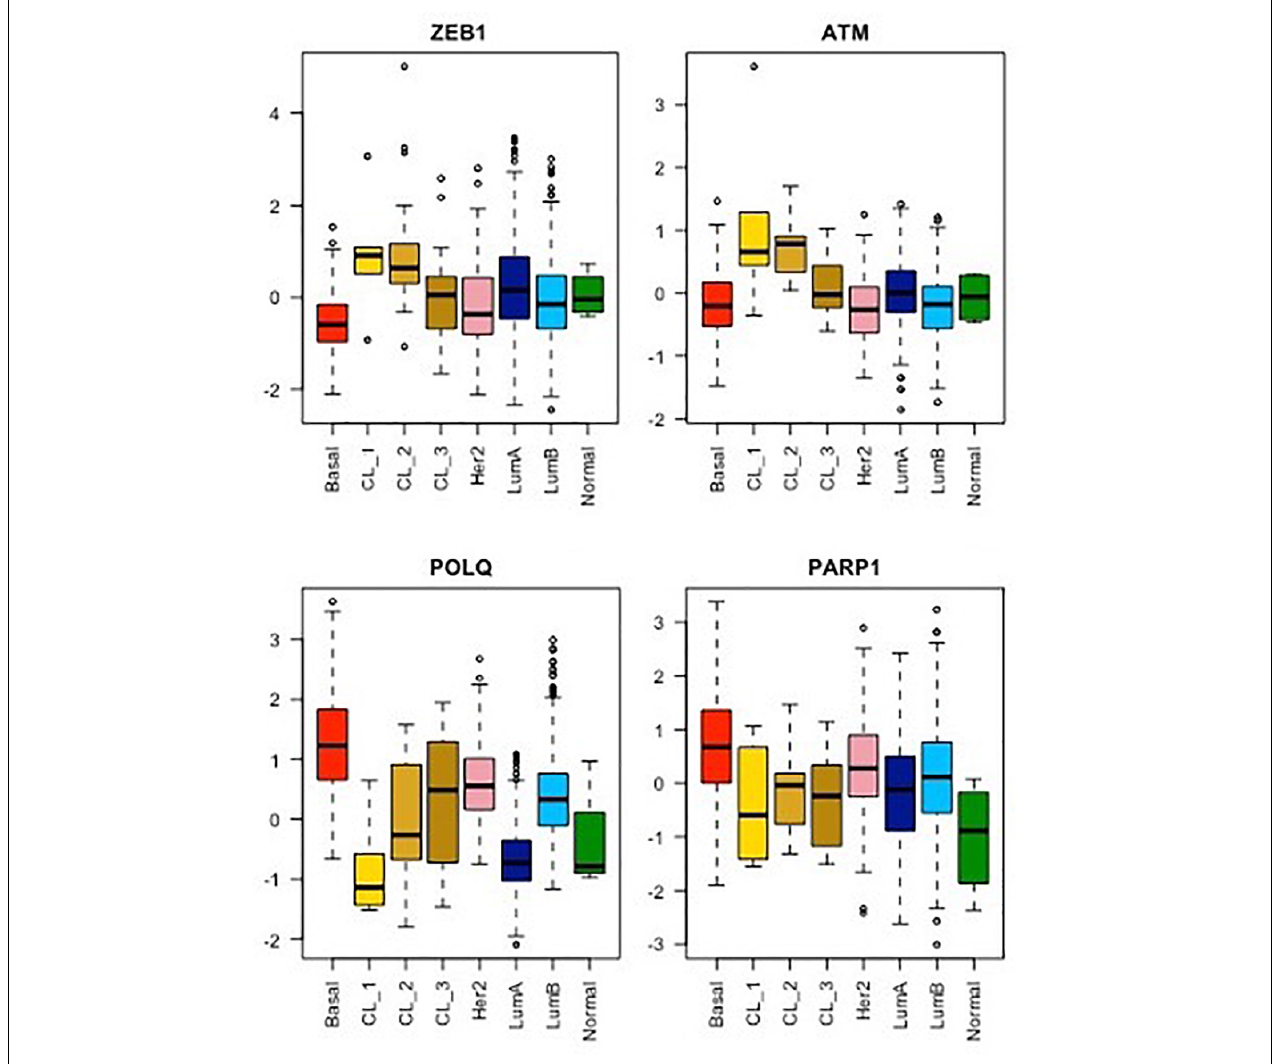
FIGURE 2 | mRNA expression analysis of ZEB1, ATM, POLQ, and PARP1 for each breast cancer molecular subtype from the METABRIC cohort. As already shown, the CL1 subgroup shows the highest stemness and EMT phenotype, exemplify here by ZEB1 expression, while CL2 and CL3 subgroups display an intermediate stemness and EMT phenotype compared to their relative luminal/basal counterparts and CL1 tumors (Pommier et al., 2020). The mRNA levels of ATM, a major player in DDR signaling, as well as of POLQ and PARP1 , two major players in TMEJ, were analyzed for all breast cancer subtypes using the same method. Wilcoxon tests. Boxplot: center line, median; box limits, upper and lower quartiles; whiskers, minimum to maximum; all data points are